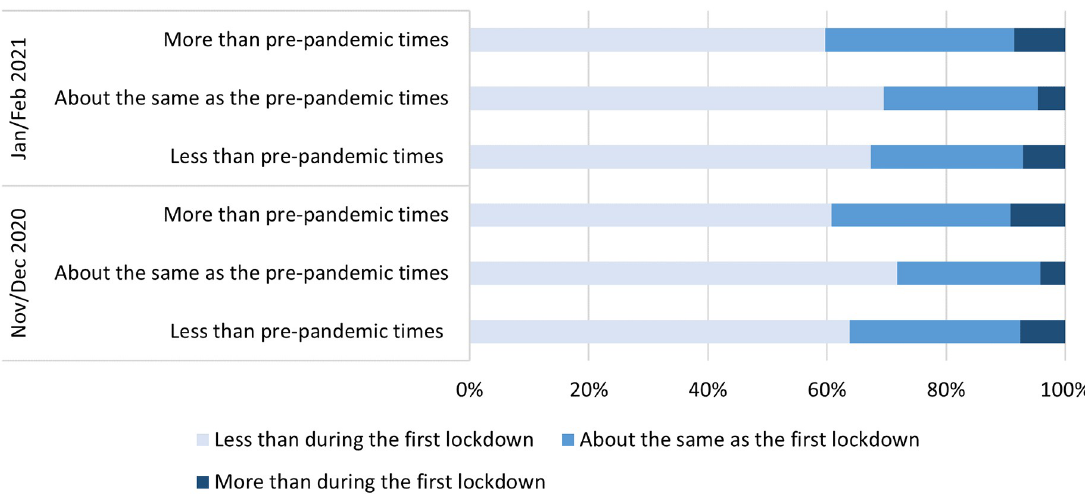
Fig 1. Changes in arts engagement levels between first lockdown in April/May 2020, second lockdown in November/December 2020, and third lockdown in January/February 2021.